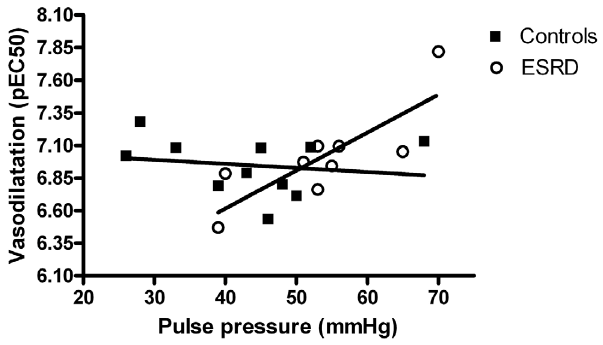
Figure 7. Association between S-Phosphate and EDH-like relaxation (pEC 50 ) in controls (r= 2 0.66; p , 0.05) and ESRD (r= 2 0.30; p=0.18), Pearson one-tailed correlation.